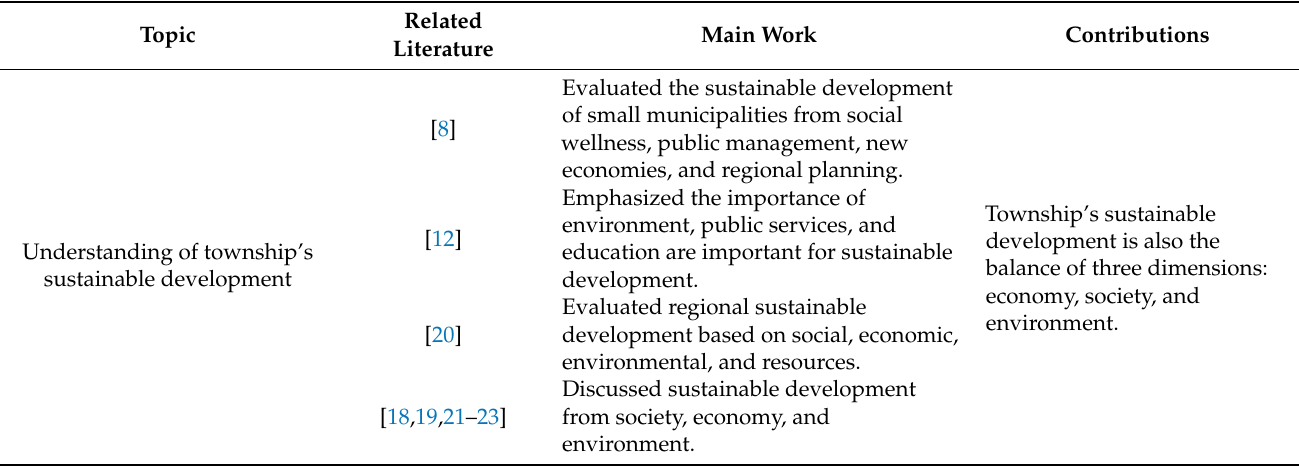
Table 1. List of the main work and contributions in the